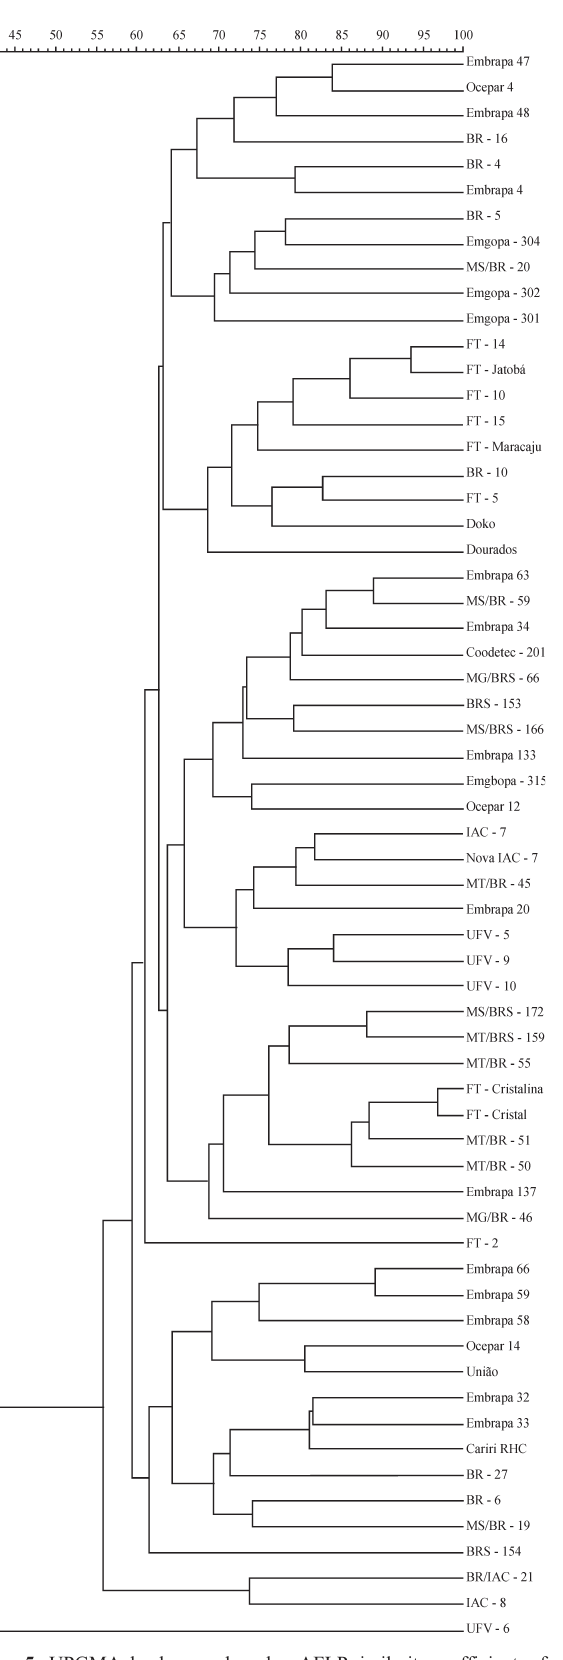
Figure 5 - UPGMA dendrogram based on AFLP similarity coefficients of 62 soybean cultivars and cophenetic correlation at the